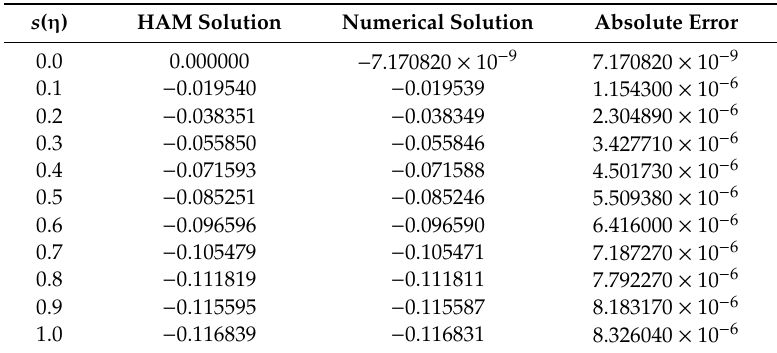
Table 4. Comparison of HAM and numerical solution for s ( η